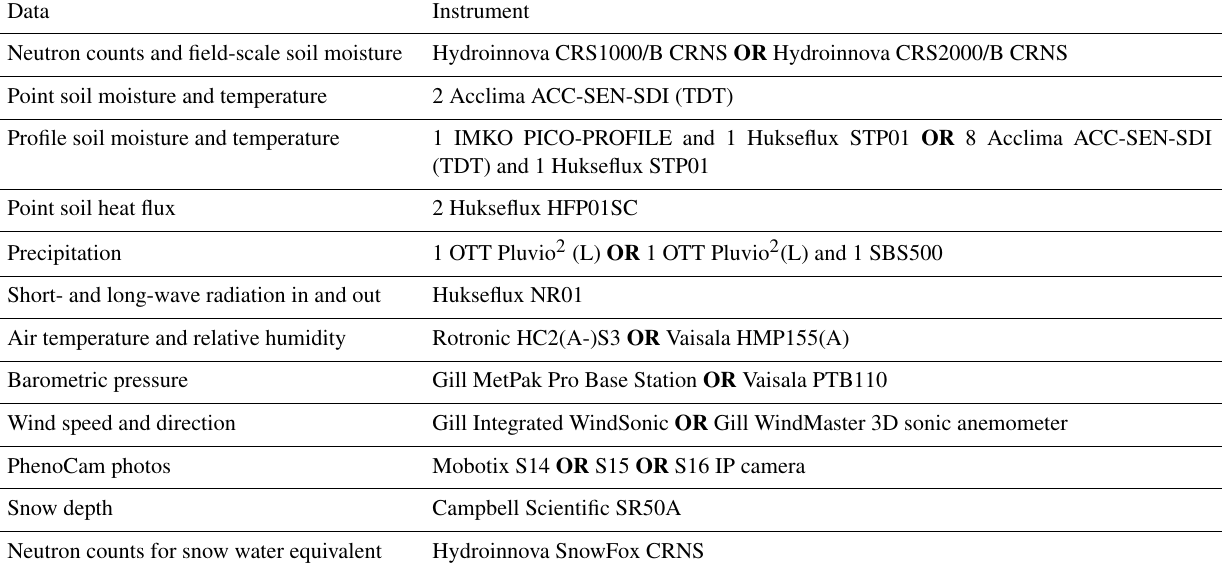
Table 3. COSMOS-UK site instrumentation. The snow depth SR50A sensors and SnowFox CRNS are only at sites established as sites experiencing significant periods of snow